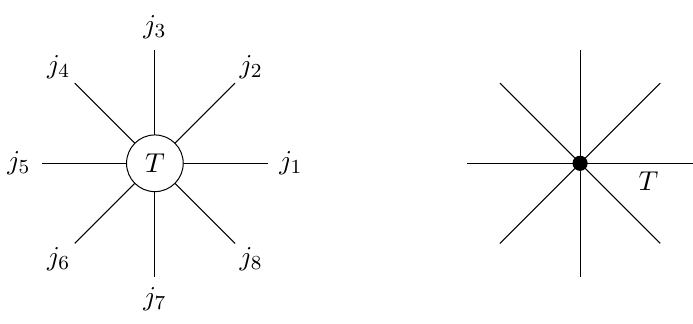
Figure 1 . In the usual tensor network notation, a tensor T with, say, seven indices is depicted as a node with seven legs (left diagram). We will follow the convention that the (cid:12)rst leg is the one following the name of the tensor (here T ) in counter-clockwise